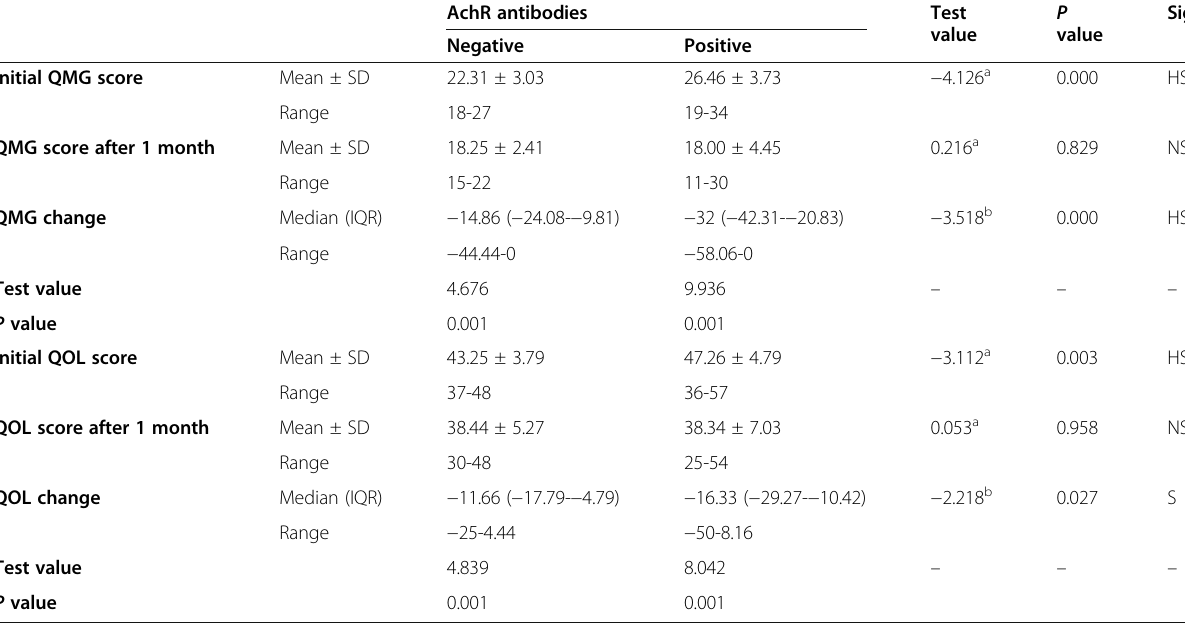
Table 3 Relation between Ach antibodies of the studied patients and QMG and QOL scores